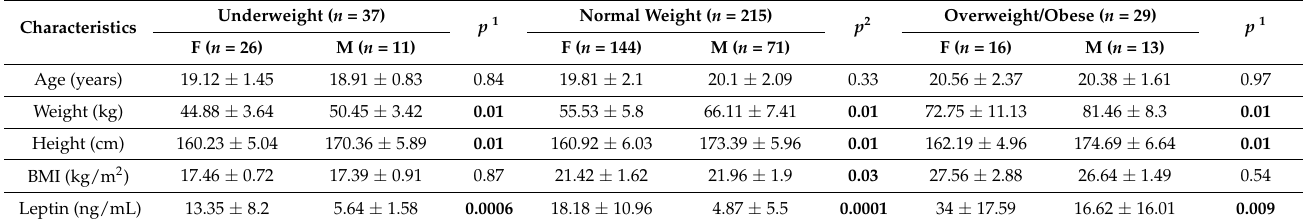
Table 1. Characteristics of study subjects by BMI and gender.